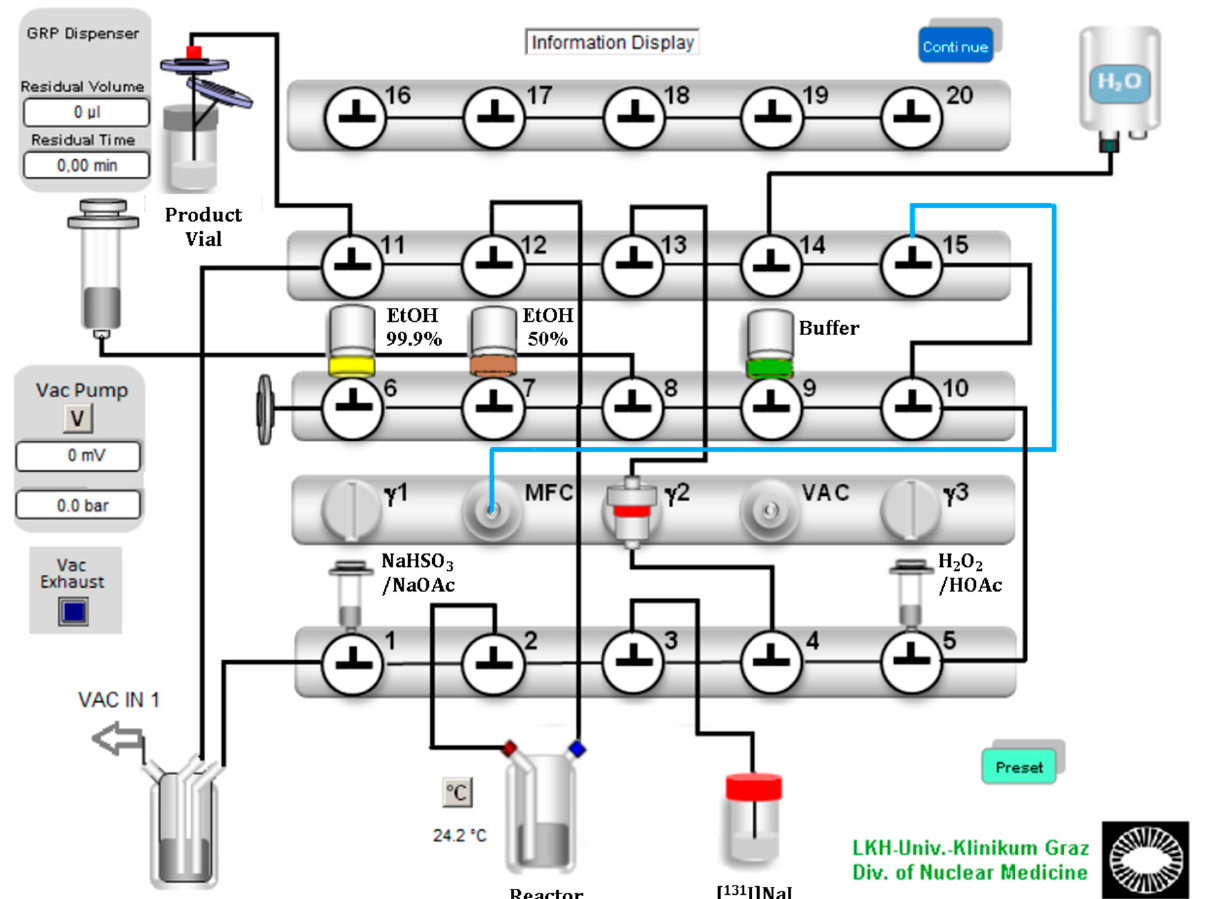
Figure 2. Configuration of the Scintomics GRP module for the labeling of [ 131 I] β -CIT and [ 131 I]FP-